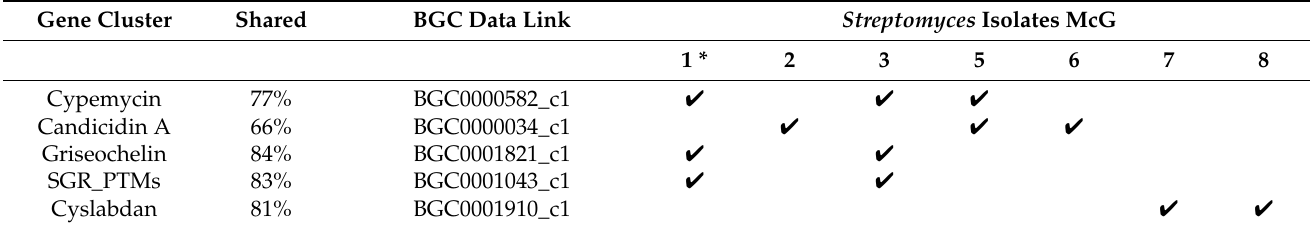
Table 5. Biosynthetic gene cluster (BGC) similarities between Streptomyces isolates and known antimicrobial synthesis genes. The biosynthetic gene clusters are hyperlinked to their corresponding matches in the Minimum Information about a Biosynthetic Gene cluster (MIBiG) repository. Abbreviation: Streptomyces griseus polycyclic tetramate macrolactam (SGR PTM). * Streptomyces sp. McG1